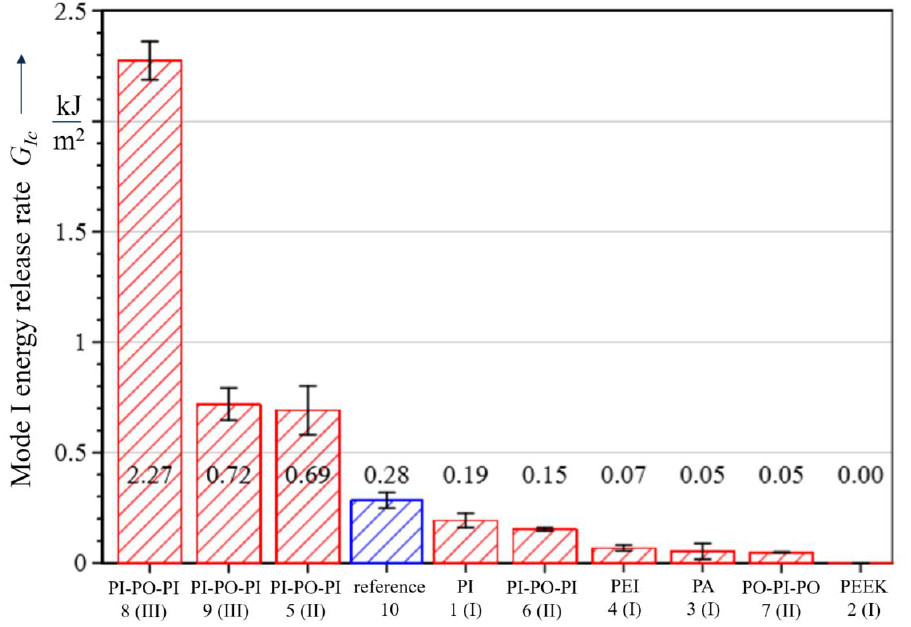
Figure 6. Mode I energy release